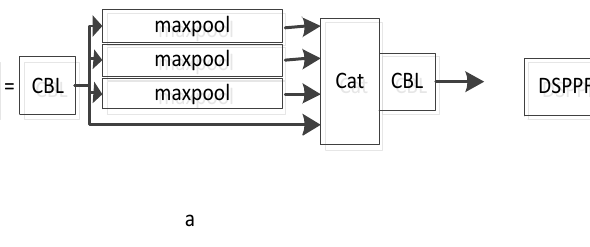
Figure 6. Comparisons of different SPPF and DSPPF modules: ( a ) Default SPPF module. ( b ) DSPPF module (ours). The feature maps are denoted by feature dimensions, e.g., D_conv denotes dilated convolutions, and k = 3, 5, and 7 are the mean sizes of the convolution kernel. maxpool denotes maximum pooling operation. CBL denotes general convolution operation, batch normalization, and Relu activation function. “Cat” represents the characteristic concatenation operation.